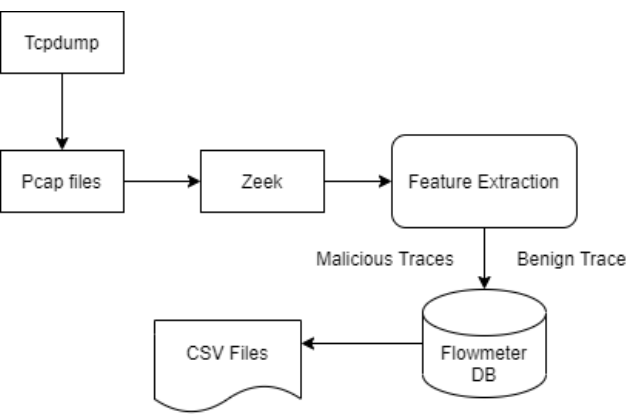
Figure 3. The preprocessing flow of HIKARI-2021 dataset.